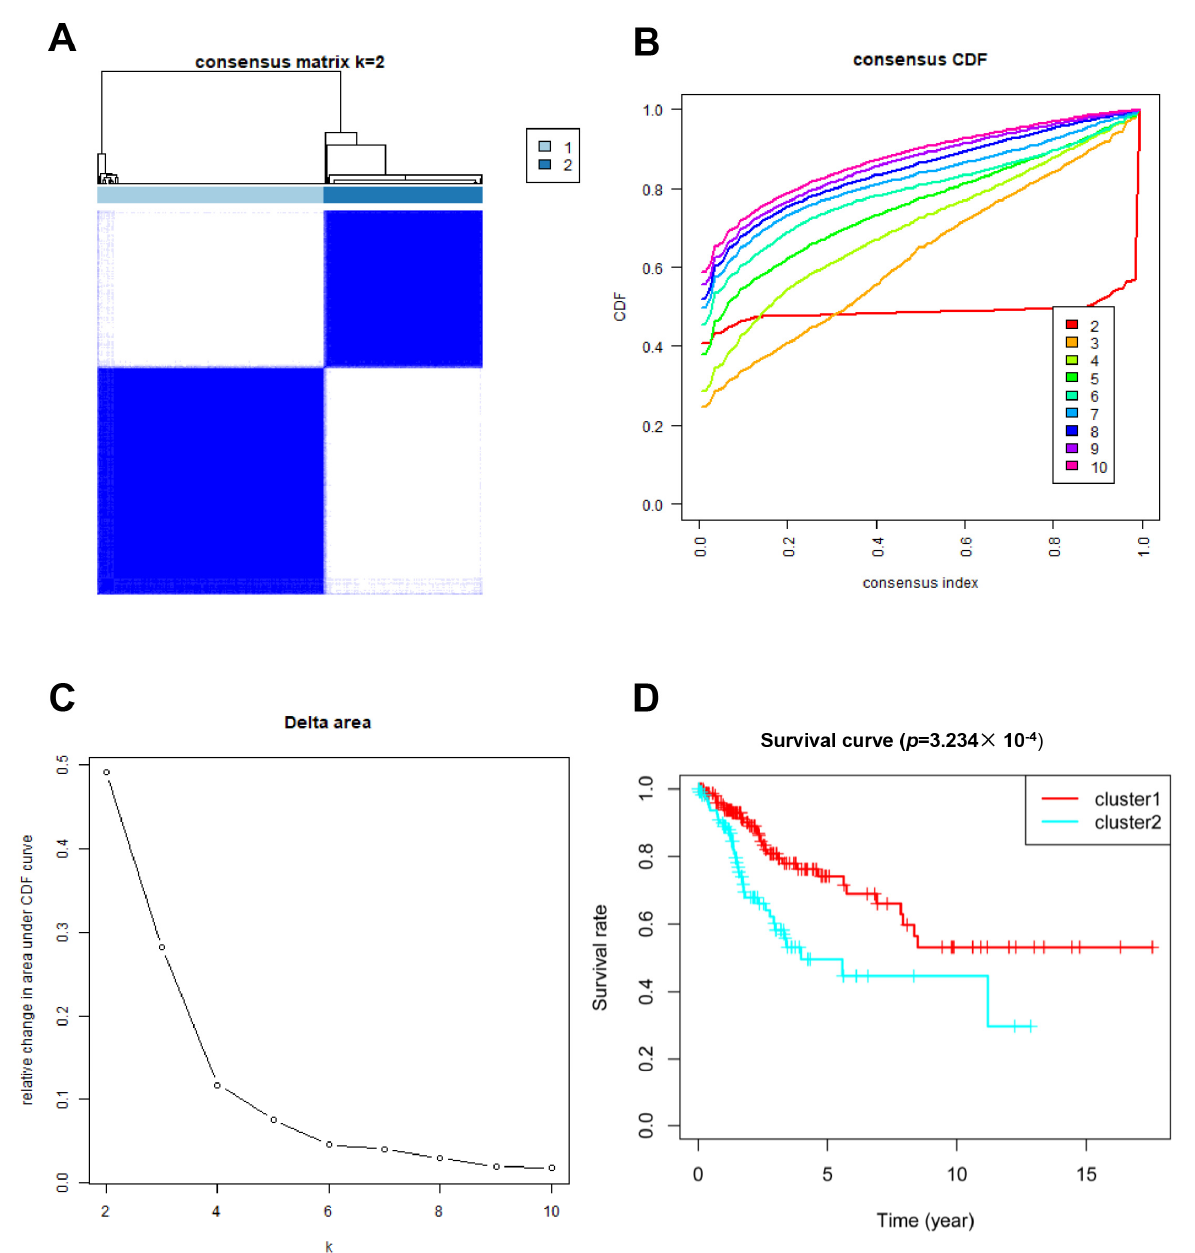
Figure 1. Clustering analysis based on the expression of glycosylation-related genes. ( A – C ) Consensus clustering for k = 2; ( D ) Patient survival curves for the two subgroups.